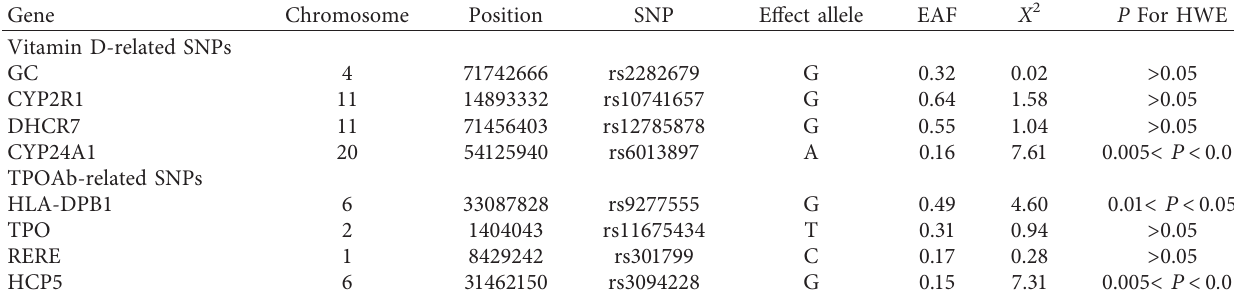
Table 1: Information of each SNP in